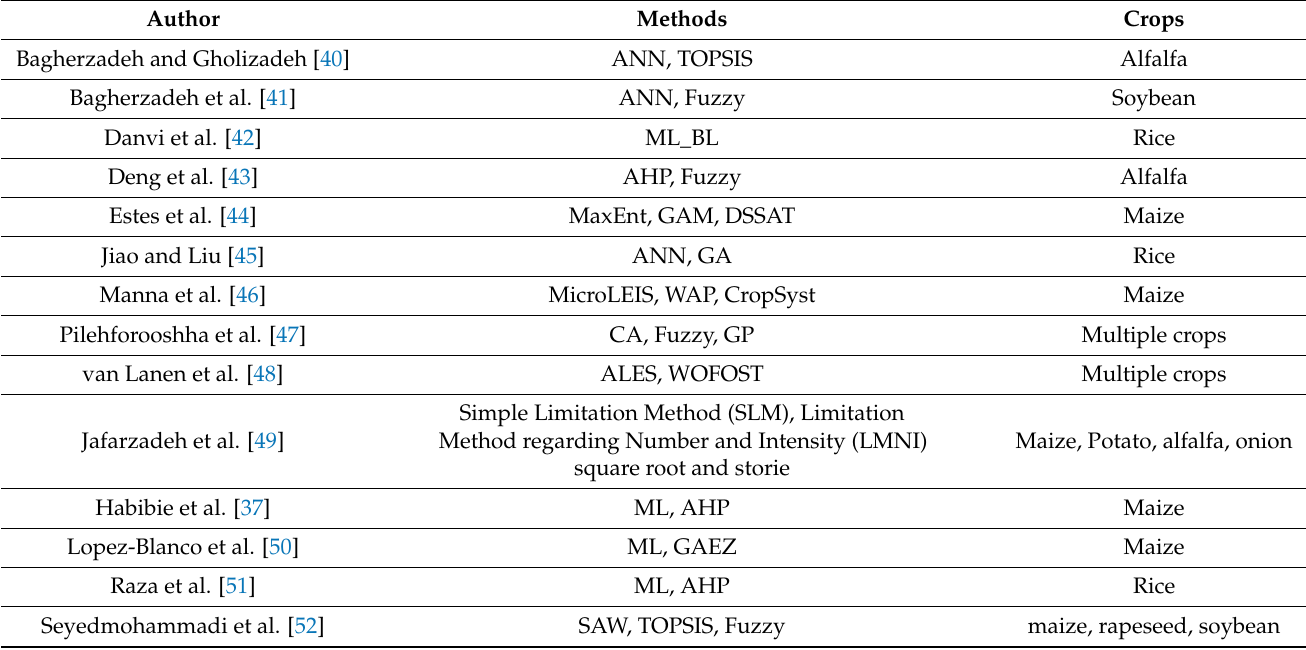
Table 1. Description of hybrid land evaluation systems used in cropland suitability